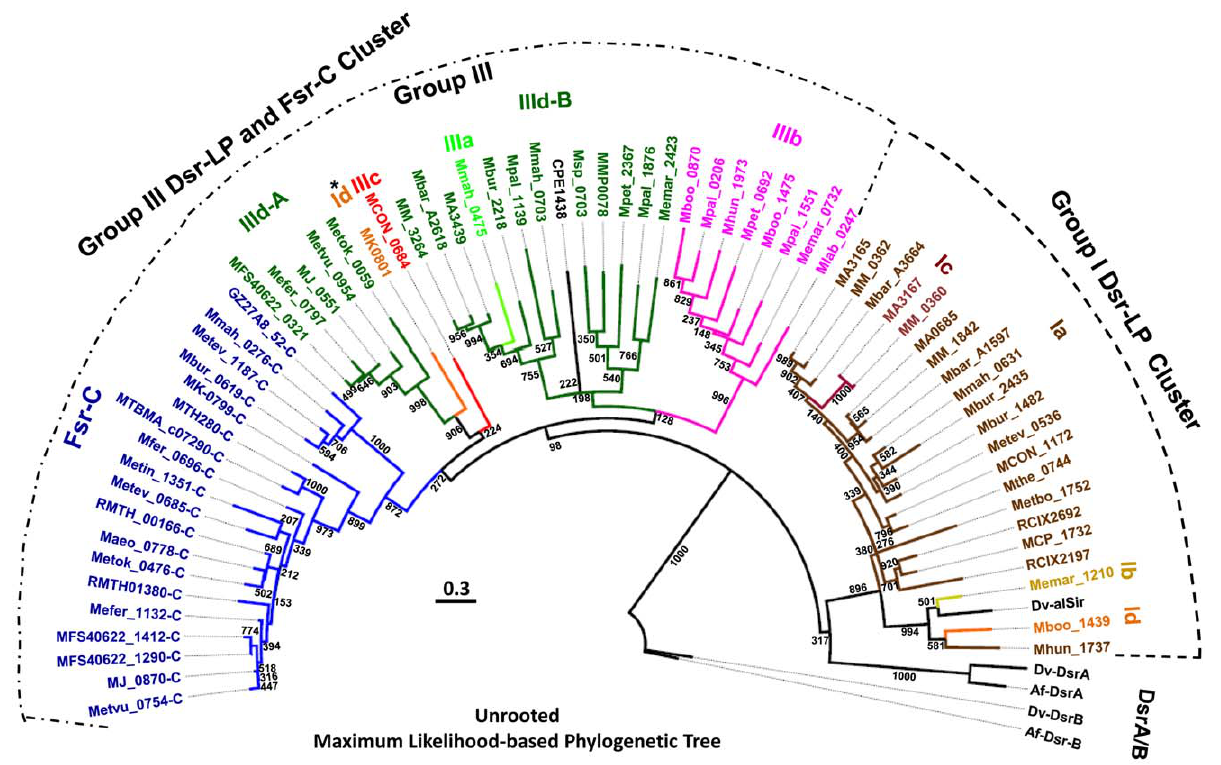
Figure 4. Phylogenetic tree of Dsr-LP and Dsr based on Maximum Likelihood method. Dsr-LP (Groups Ia-d and IIIa-d) and Dsr, defined in Fig. 3 and its legend. Dsr and Fsr-C, defined in the legend of Fig. 1. Dv-DsrA/B and Af-DsrA/B, Dsr subunits A and B of Desulfovibrio vulgaris strain Hildenborough (ORFs DVU0402 and DVU0403) and Archaeoglobus fulgidus DSM 4304 (ORFs AF0423 and AF0424), respectively [64,65]; Dv-alSir and CPE1438, anaerobic small sulfite reductase of Desulfovibrio vulgaris strain Hildenborough (ORF DVU_1597) and Clostridium perfringens strain 13, respectively [66]; The ORF numbers followed by ‘‘-C’’, Fsr-C homologs. Abbreviation for organism names preceding the listed ORF numbers: MTBMA, Methanothermobacter marburgensis strain Marburg; MTH, Methanothermobacter thermautotrophicus D H; Metbo, Mehanobacterium sp. AL-21; RMTH, Methanothermococcus thermolithotrophicus (sequence obtained from Dr. William B. Whitman, University of Georgia); Mfer, Methanothermus fervidus DSM 2088; Maeo, Methanococcus aeolicu s Nankai-3; Msp, Methanosphaera stadtmanae DSM 3091; MMP, Methanococcus maripaludis S2; Mpal, Methanosphaerula palustris E1-9c ; Mpet, Methanoplanus petrolearius DSM 11571 ; Memar, Methanoculleus marisnigri JR1; MM, Methanosarcina mazei Go¨1; MA, Methanosarcina acetivorans C2A; Mbar, Methanosarcina barkeri strain Fusaro ; Mbur, Methanococcoides burtonii DSM 6242; Mmah, Methanohalophilus mahii DSM 5219; Metev, Methanohalobium evestigatum Z-7303; Mthe, Methanosaeta thermophila PT; MCON, Methanosaeta concilii GP-6; MCP, Methanocella paludicola SANAE; Mboo, Candidiatus Methanoregula boonei 6A8; Mlab, Methanocorpusculum labreanum Z; Mhun, Methanospirillum hungatei JF-1; Metbo, Methanobacterium sp. Al-21; Metok, Methanothermococcus okinawensis IH1; Metin, Methanocaldococcus infernus ME; MFS40622, Methanocaldococcus sp. FS406-22; MJ, Methanocaldococcus jannaschii DSM 2661; Mefer, Methanocaldococcus fervens AG86; Metvu, Methanocaldococcus vulcanius M7; MK, Methanopyrus kandleri AV19; GZ27A8_52, uncultured archaeon related to Methanosarcina and a member of an anaerobic methane oxidizing consortium; RCIX2692 and RCIX2197, uncultured methanogenic archaeon RC-1 and primary methane producer in rice rhizosphere. The bootstrap value shown at each branch is from 1000 replicates. Scale bar, number of amino acid substitutions per site. *, shows outliers. A and B, sub-clades of group